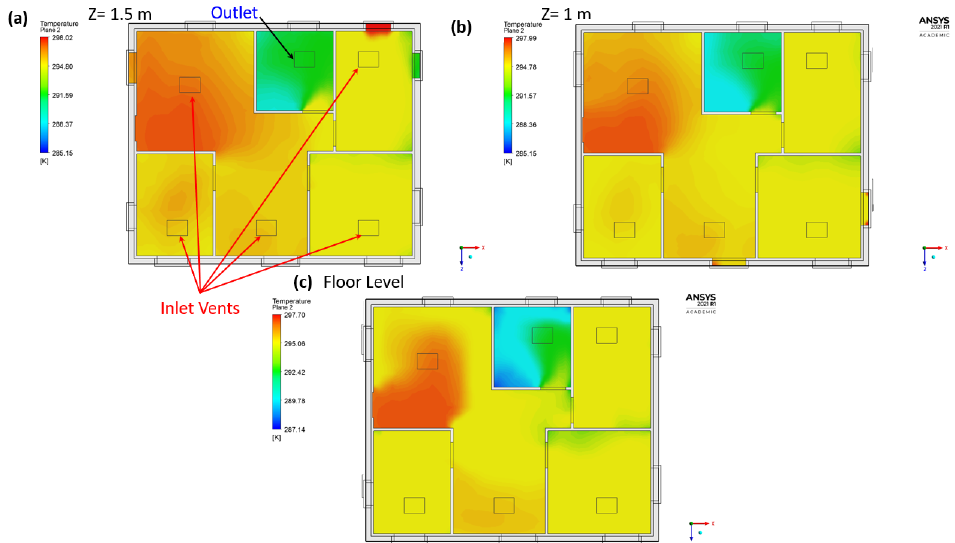
Figure 6. Temperature profiles distribution for the house (top view) using ASHRAE 55-2017 inlet temperature 25 ℃ at different heights ( a ) 1.5 m, ( b ) 1 m, and ( c ) the (finished) floor.